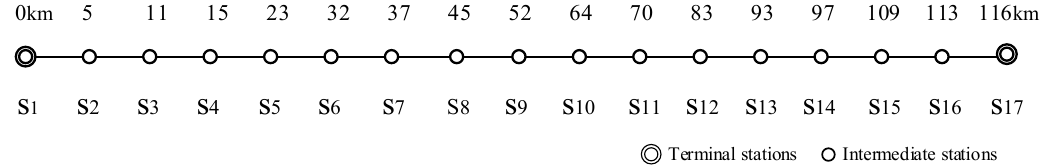
Figure 3. A certain intercity railway.